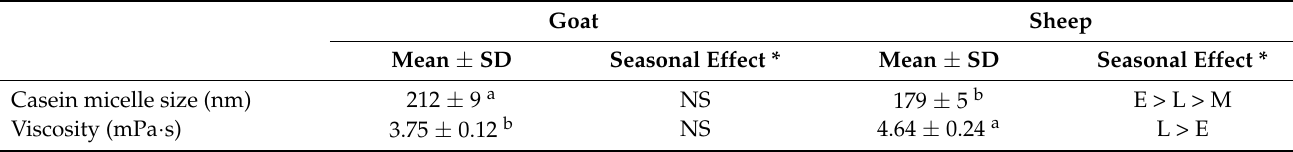
Table 4. Cont. Goat Sheep Mean ± SD Seasonal Effect * Mean ± SD Seasonal Effect * 212 ± 9